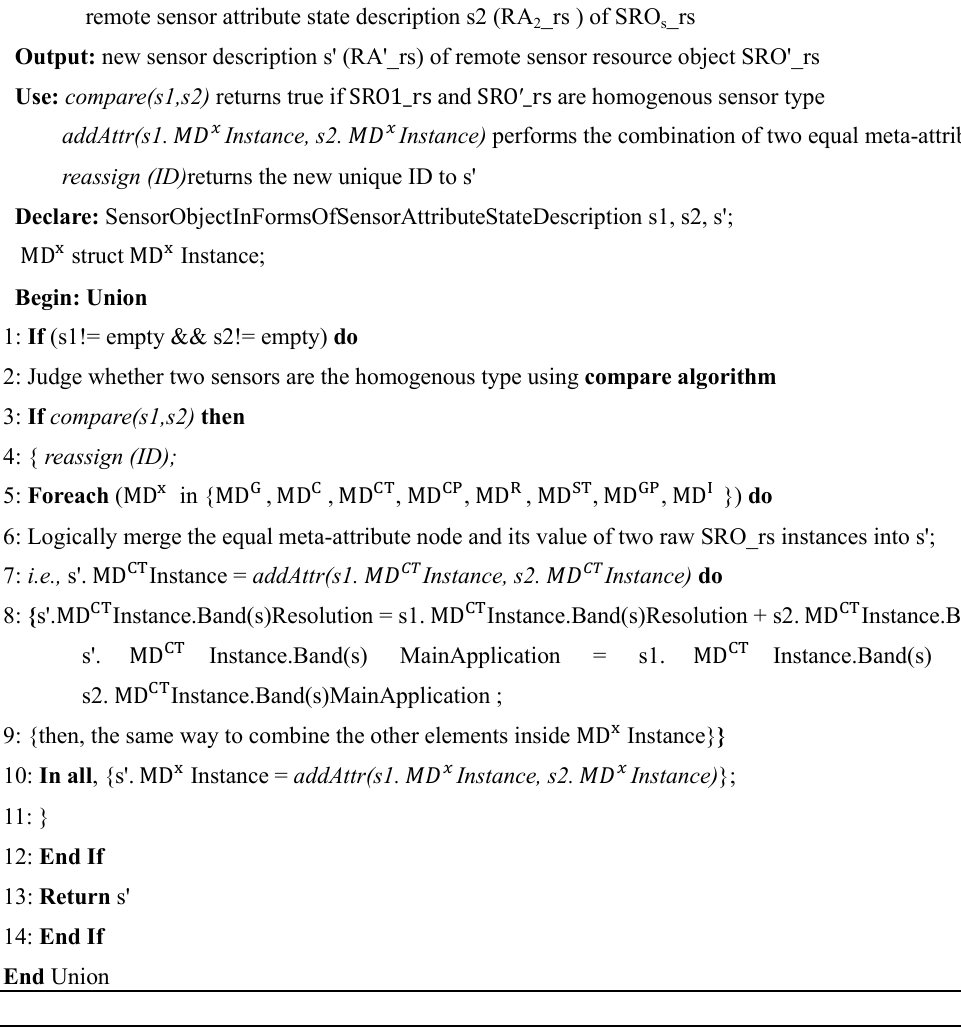
Algorithm1: Union algorithm of two remote sensor resource objects SRO_rs instances